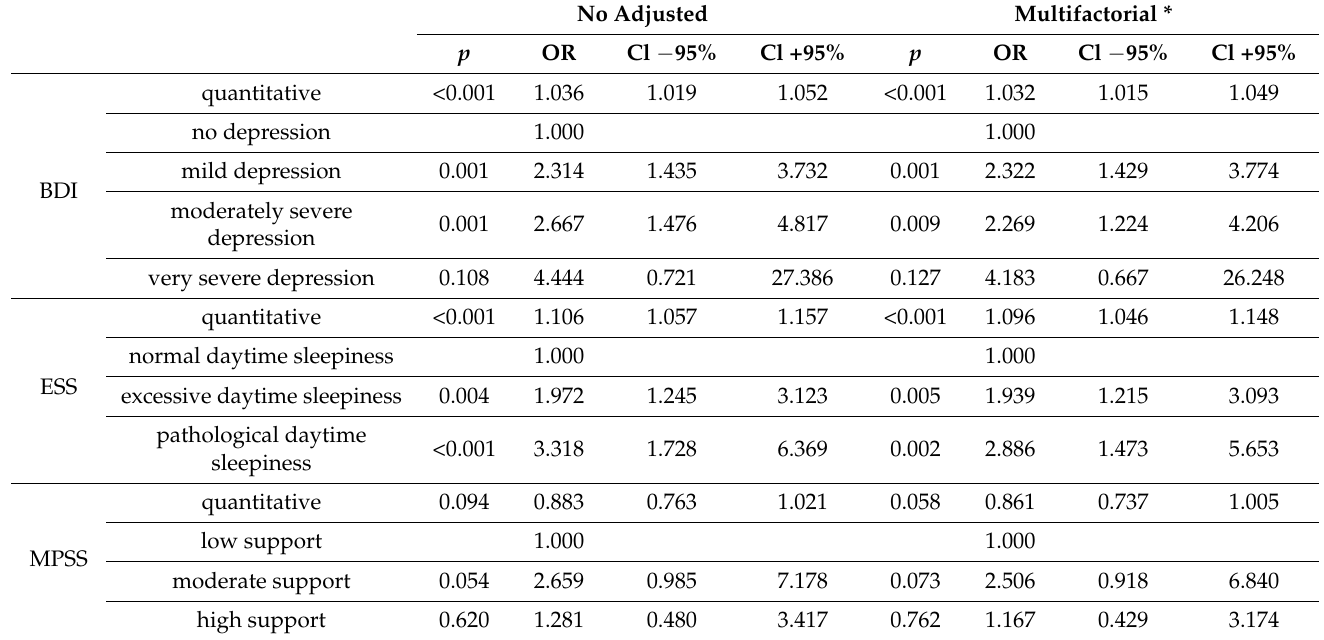
Table 3. Univariate and multivariate regression for respondents with problematic mobile phone